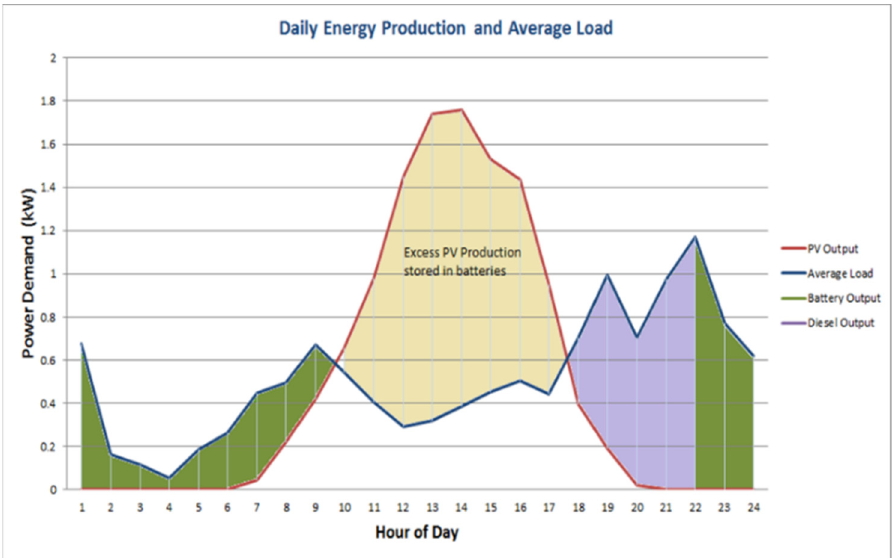
Figure 11. An illustration of how HOMER dispatch energy in a hybrid renewable energy system.